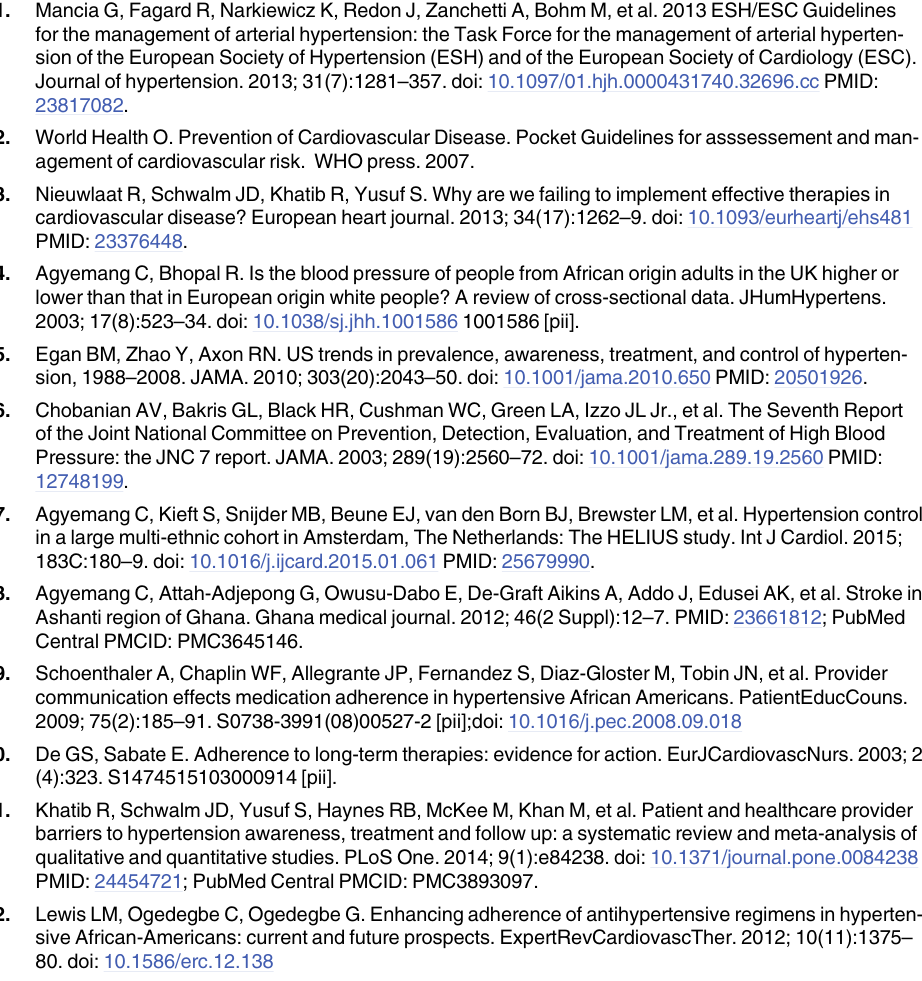
‘ Lifestyle adherence ’ . Table E: Extra information about outcome measure ‘ Change in Life- style adherence ’